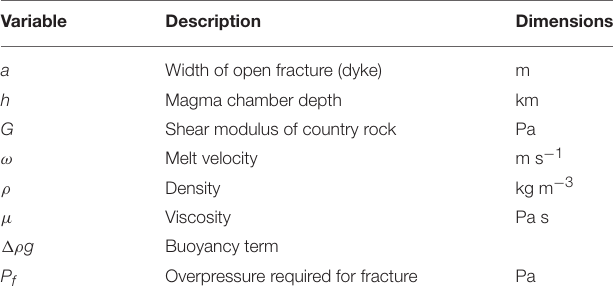
TABLE 1 | Parameters used in eruption